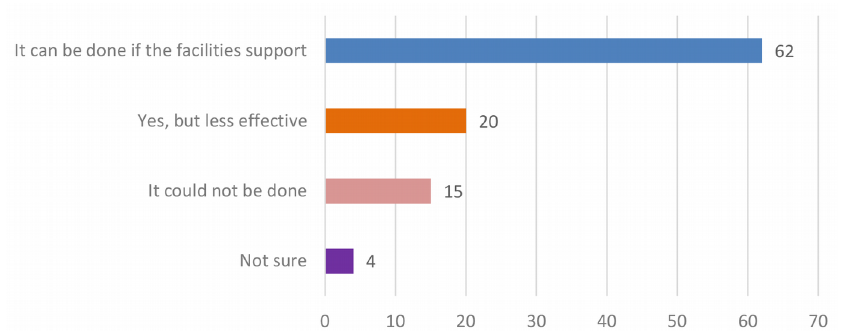
Figure 7. Possibility of implementation of STEM during COVID-19